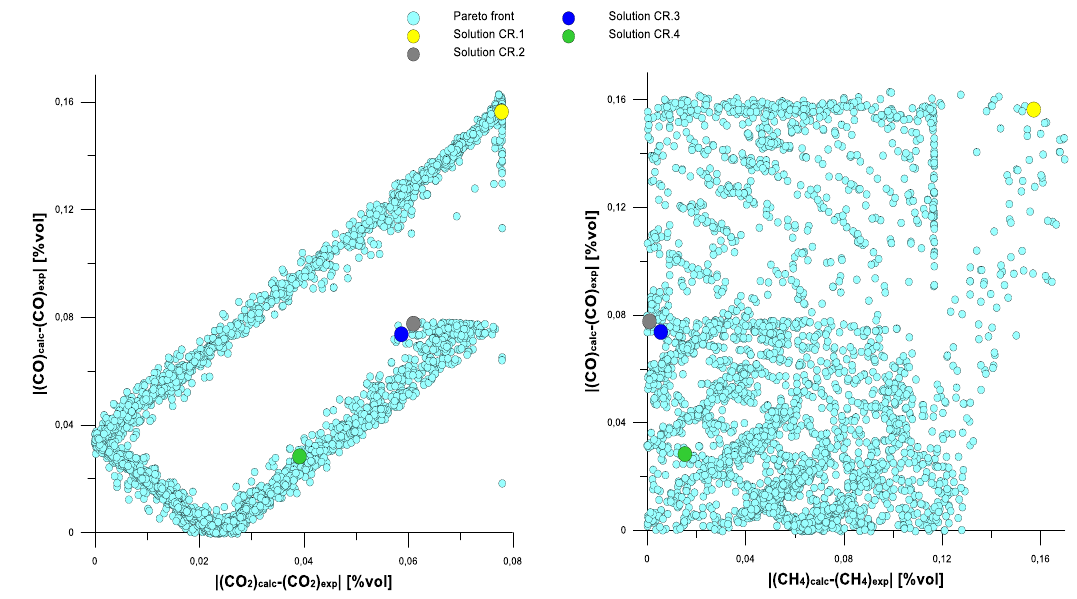
Figure 6. Pareto Front (syngas volume concentration of 𝐶𝑂 2 , CO and 𝐶𝐻 4 , CO).